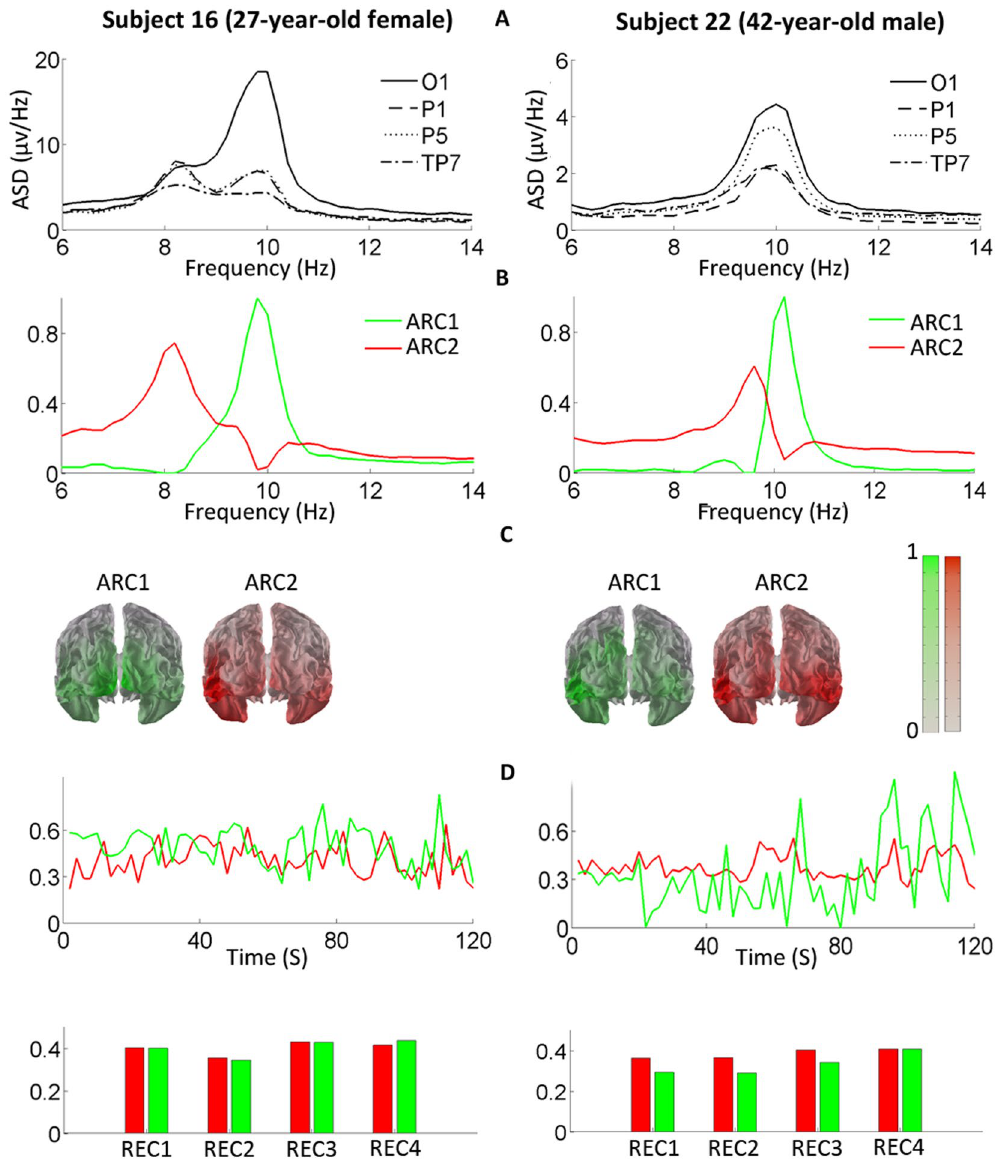
Figure 2. Individual examples of two-component structure of alpha rhythm. ( A ) The amplitude spectrum densities (ASD) of an EEG from posterior electrodes (O1, P1, P5, and TP7 according to the Extended 10/20 System) are presented in the conventional alpha frequency range. ( B ) The frequency loadings of the two ARCs extracted with PARAFAC1. ( C ) The normalized source distributions of the ARCs (spatial loadings of the components) are rendered on the average MNI brain (posterior view). Color indicates loading values: the higher the color intensity, the higher the loadings. ( D ) Temporal loadings of ARC1 (green lines and bars) and ARC2 (red) are shown over representative 3-minute periods (upper row) and as averages over the 4 REC periods (bottom row). The temporal fluctuations of the two components’ loadings are not correlated and both ARCs are well present over the whole EEG session (1.5–2 hours). The dimensionless loading values (y-axes in B and D ) are normalized to the maximum value of each loading